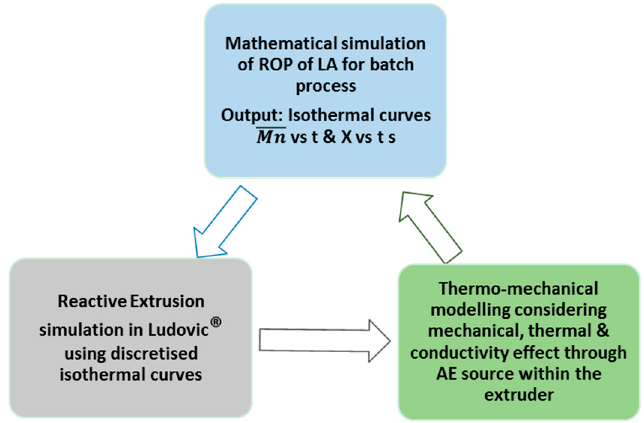
Figure 2. Input and output for continuous extrusion simulation.